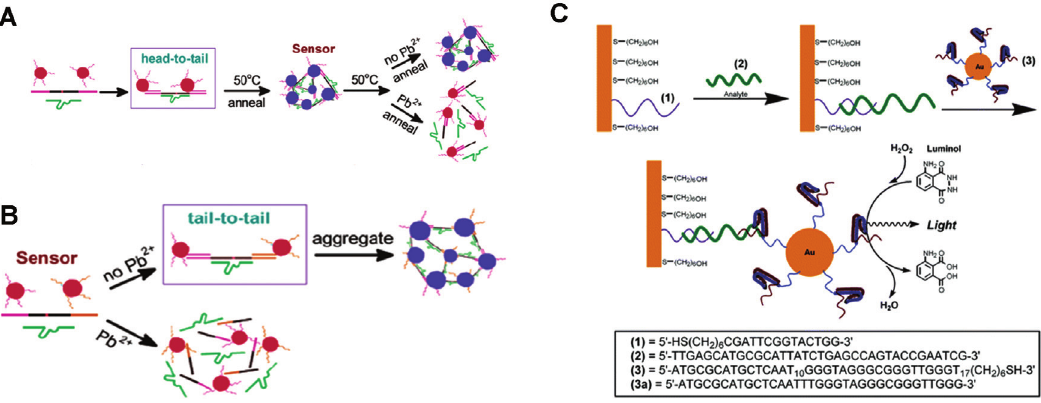
Figure 2 Pb 2+ -directed assembly of gold nanoparticles by the DNAzyme when nanoparticles are aligned in a head-to-tail (A) or a tail-to- tail manner (B). Reprinted with permission from: Liu and Lu 2005. Copyright 2005, American Chemical Society. (C) Amplified chemilumi- nescence detection of DNA using DNAzyme-functionalized AuNPs. Reprinted with permission from: Willner et al. (2004). Copyright 2004, American Chemical